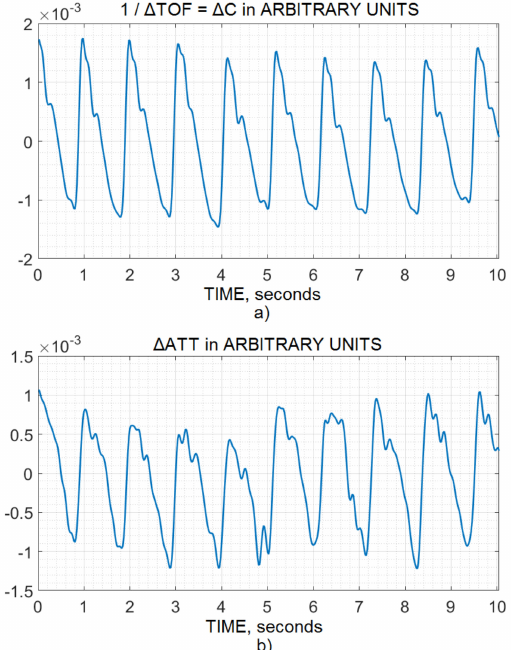
Figure 1. Intracranial volumetric pulse waves (causes of ICP waves) noninvasively and simultaneously recorded by ( a ) an ultrasonic time-of-flight recording method and ( b ) an attenuation recording method inside an acoustic path, which is crossing the skull and brain.